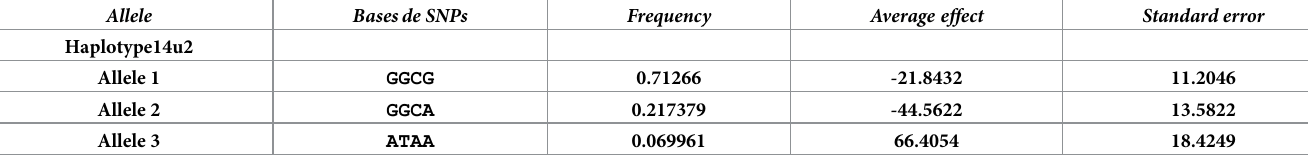
Table 3. Frequency, average effect, and respective standard error of haplotype alleles located in the XKR4 gene.